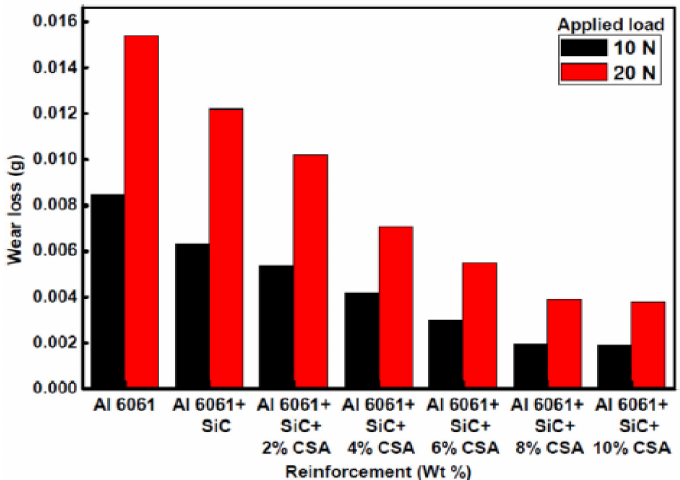
Figure 19. Wear losses of Al6061 and its composites